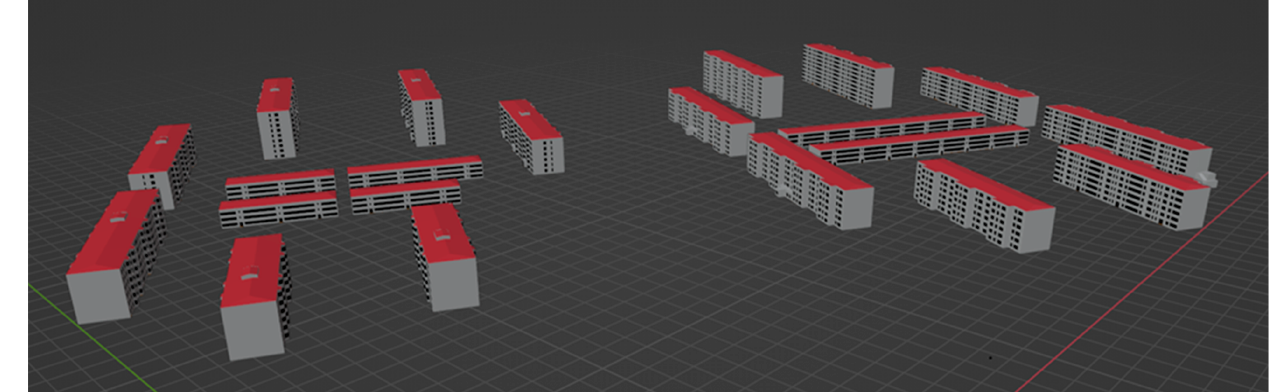
Figure 9. The building and window information (stored in CityJSON, shown in Blender).